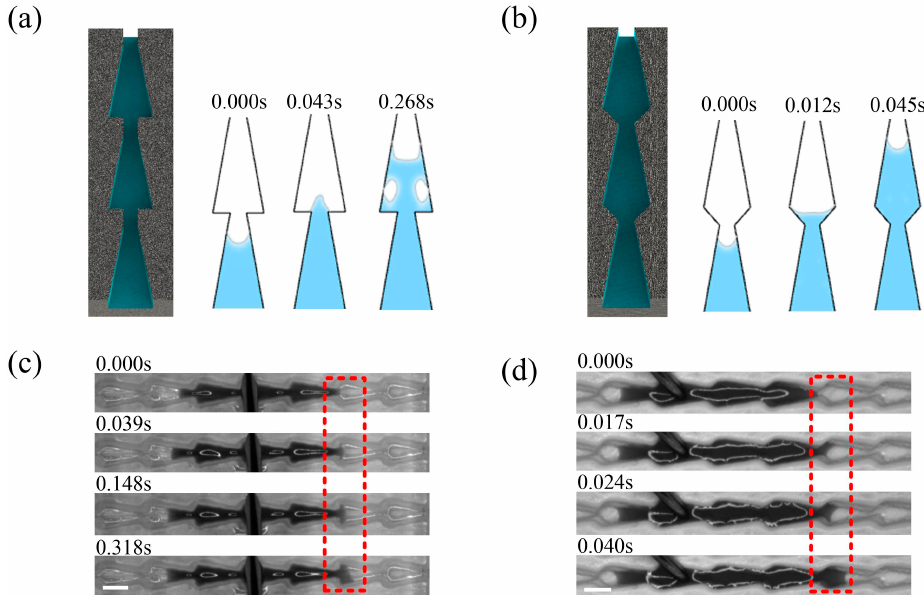
Figure 4. ( a ) Results of the COMSOL simulation with the flat-bottom conical structure. ( b ) Results of the experiment with the flat-bottom conical structure (scale bar = 1 mm). ( c ) Results of the COMSOL simulation with the arrowhead structure. ( d ) Results of the experiment with the arrowhead structure (scale bar = 1 mm).